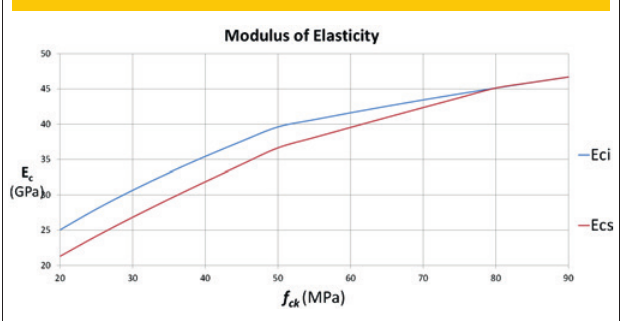
Figure 1 – Tangent and secant modulus of elasticity of concrete